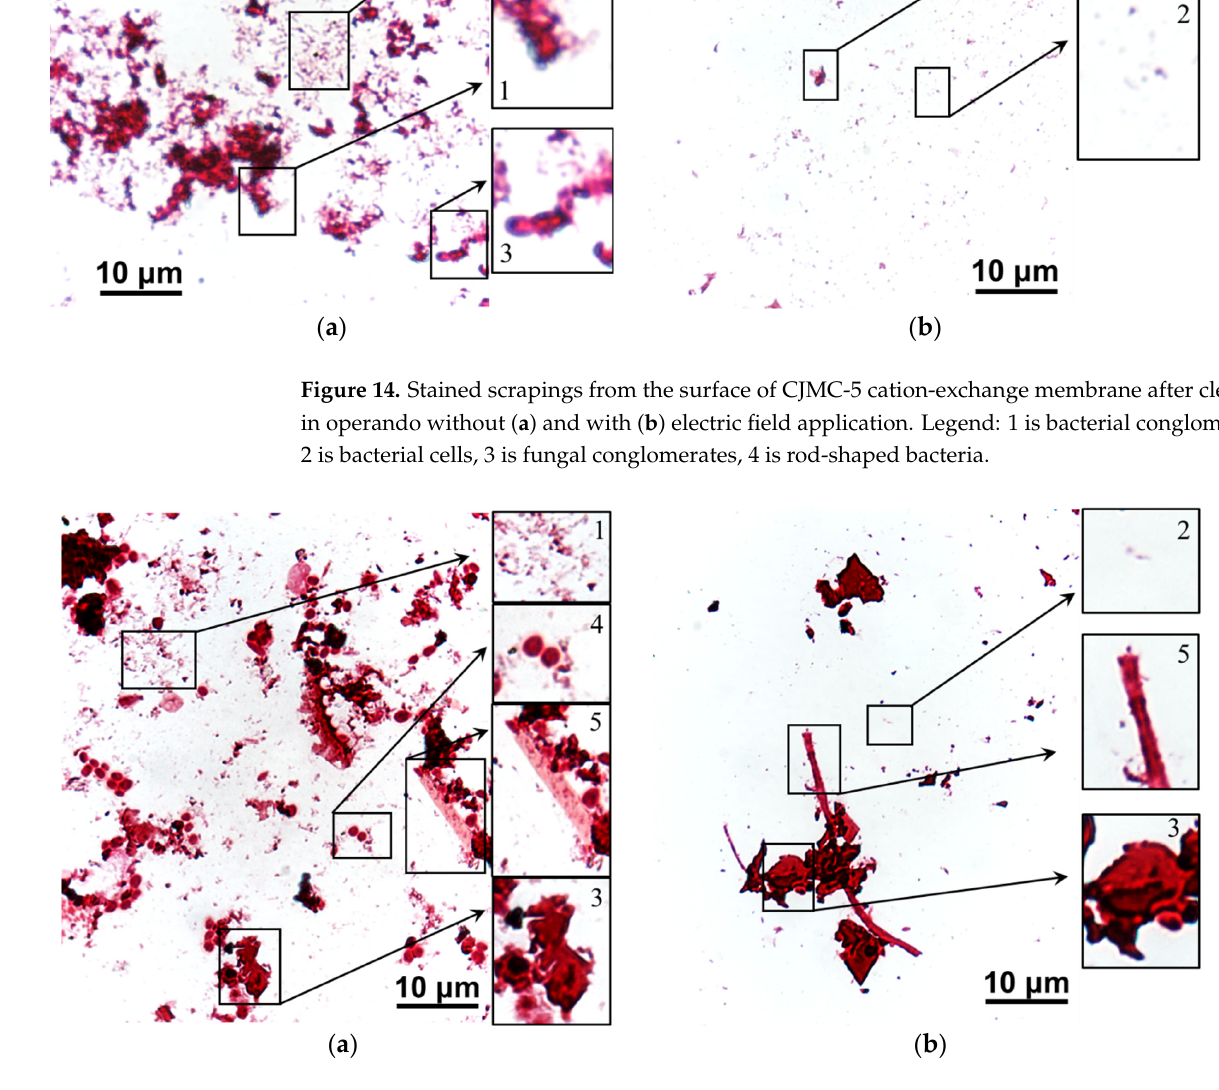
Figure 15. Stained scrapings from the surface of CJMA-6 anion-exchange membrane after cleaning in operando without ( a ) and with ( b ) electric field application. Legend: 1 is bacterial conglomerates, 2 is bacterial cell, 3 is fungal conglomerate, 4 is fungal spores, 5 is fungal mycelium.